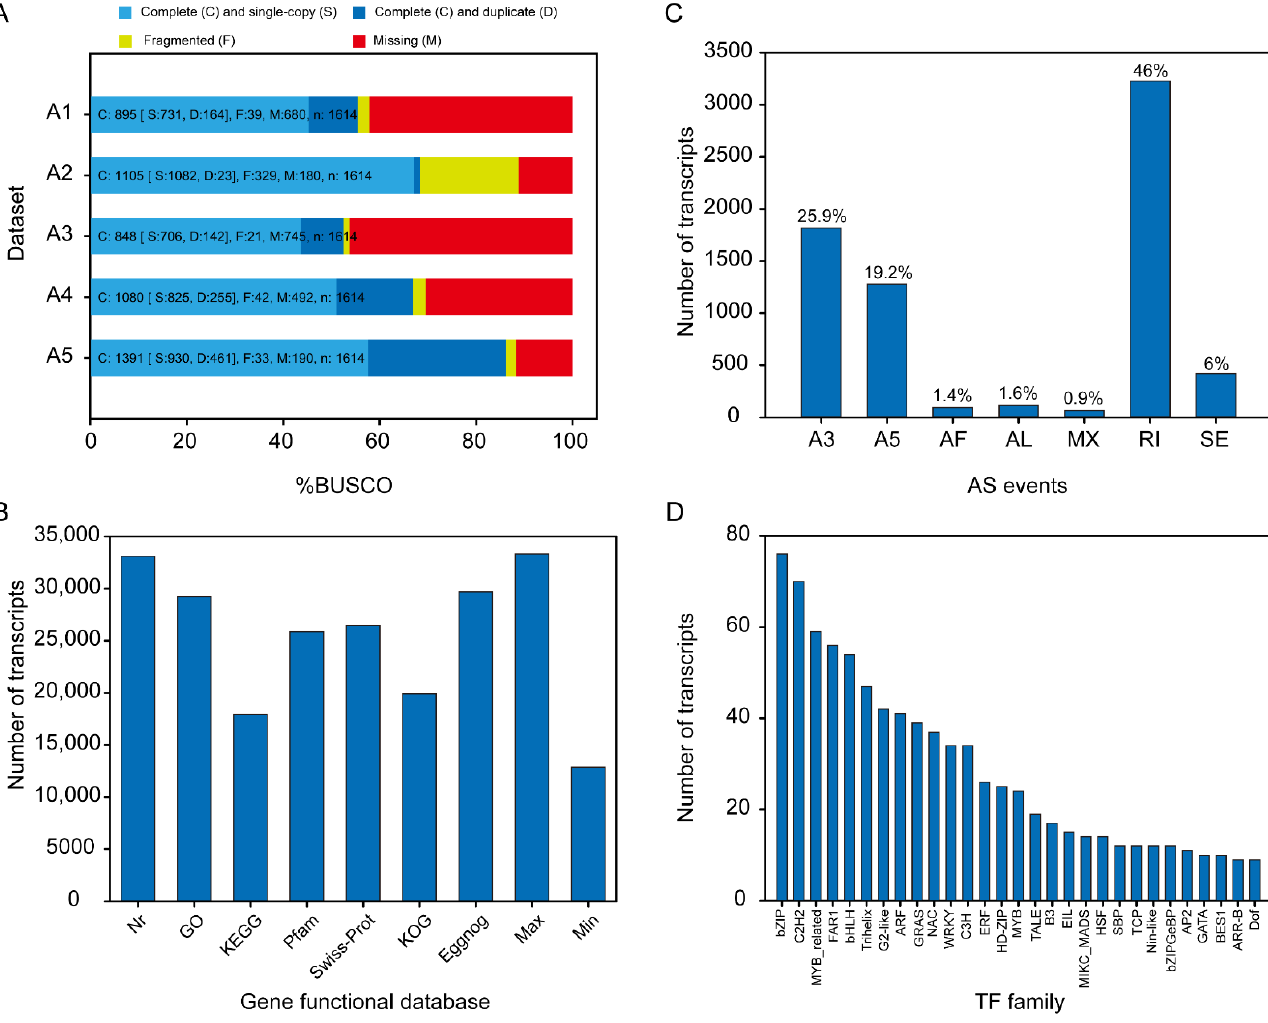
Figure 3. Transcriptome evaluation and annotation. ( A ) BUSCO assessment results for five transcriptomes with different datasets and assembly strategies. A1: PacBio-based RNA-Seq data from public database; A2: Illumina-based RNA-Seq data from our previous work; A3: PacBio-based